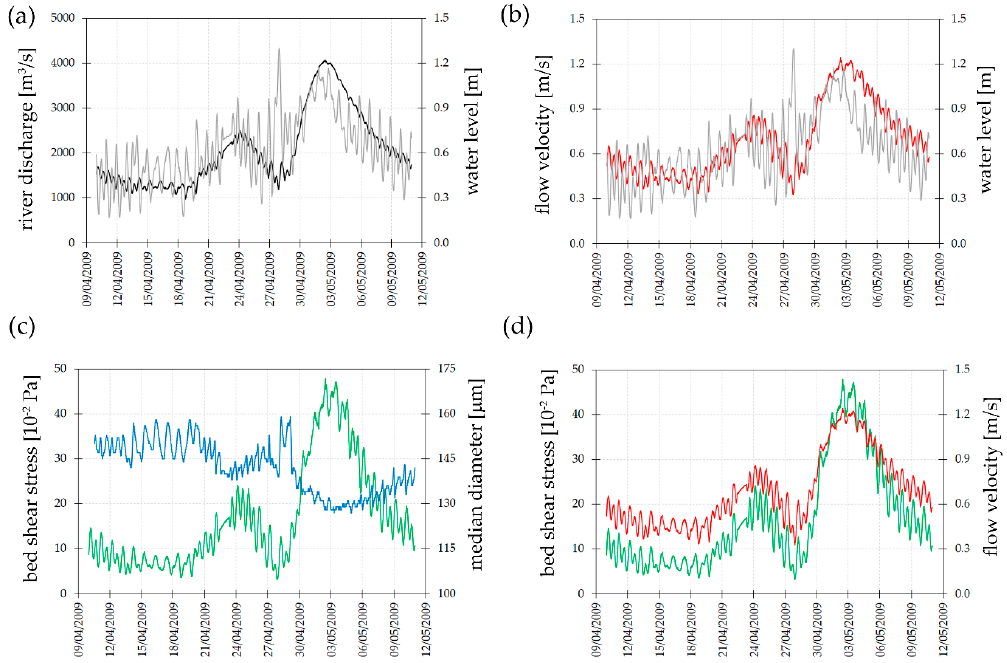
Figure 5. Simulated parameters at the gauging station of Pila: (a) river discharge (black line) vs. water level (grey line); (b) averaged flow velocity (red line) vs. water level (grey line); (c) bed shear stress level (grey line); ( b ) averaged flow velocity (red line) vs. water level (grey line); ( c ) bed shear stress (green line) vs. active median diameter d 50 (blue line); (d) bed shear stress (green line) vs. averaged (green line) vs. active median diameter d 50 (blue line); ( d ) bed shear stress (green line) vs. averaged flow velocity (red line). flow velocity (red line).